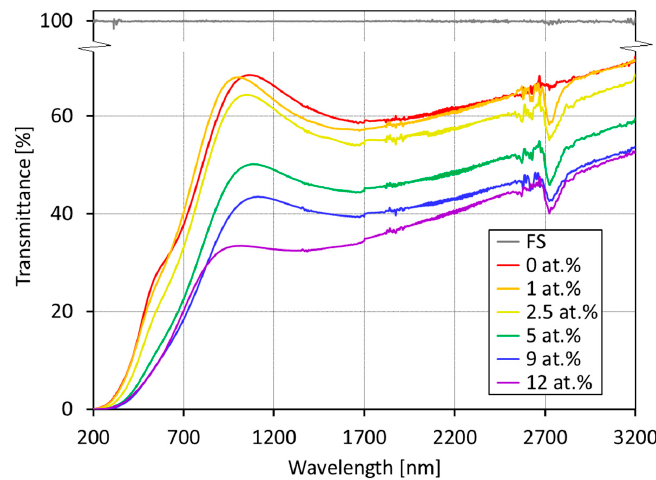
Figure 3. Transmission curves of DLC and Ge-doped DLC films in region up to 3.2 micrometers.